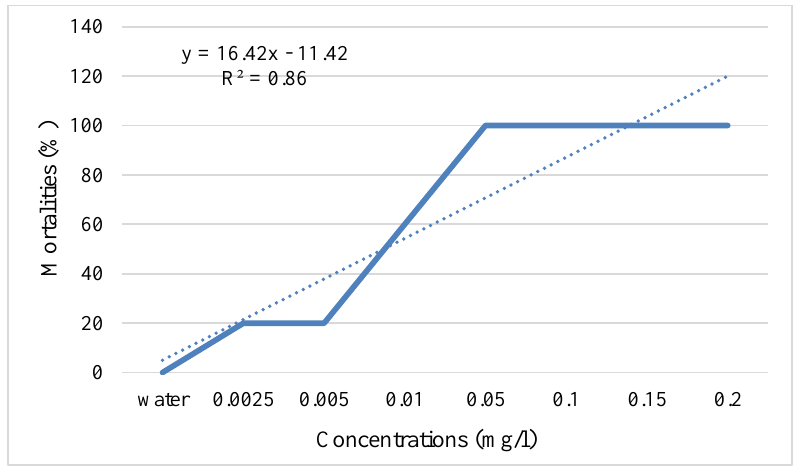
Figure 1. Tadpoles mortalities